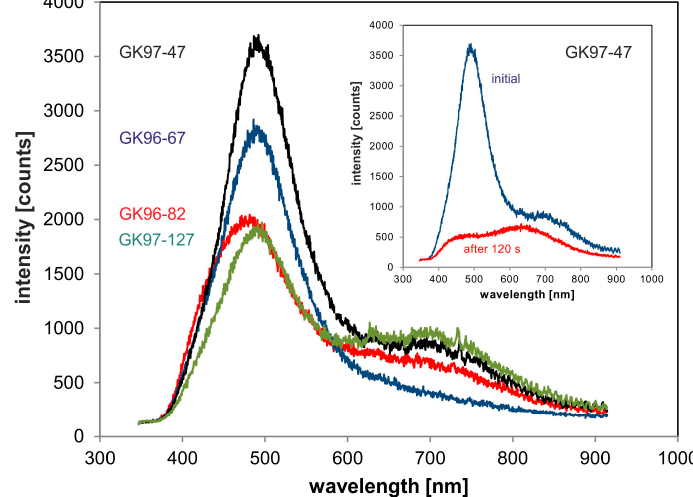
Figure 6. Initial CL emission spectra of quartz from the garnet zone (GK 96-82), staurolite zone (GK 96-67), kyanite zone (GK 97-47), and kyanite-sillimanite-muscovite zone (GK 97-127); the dominating 490 nm band strongly decreases during electron irradiation revealing the slight 450 nm band; the 650 nm emission intensity is more or less constant (see inset).